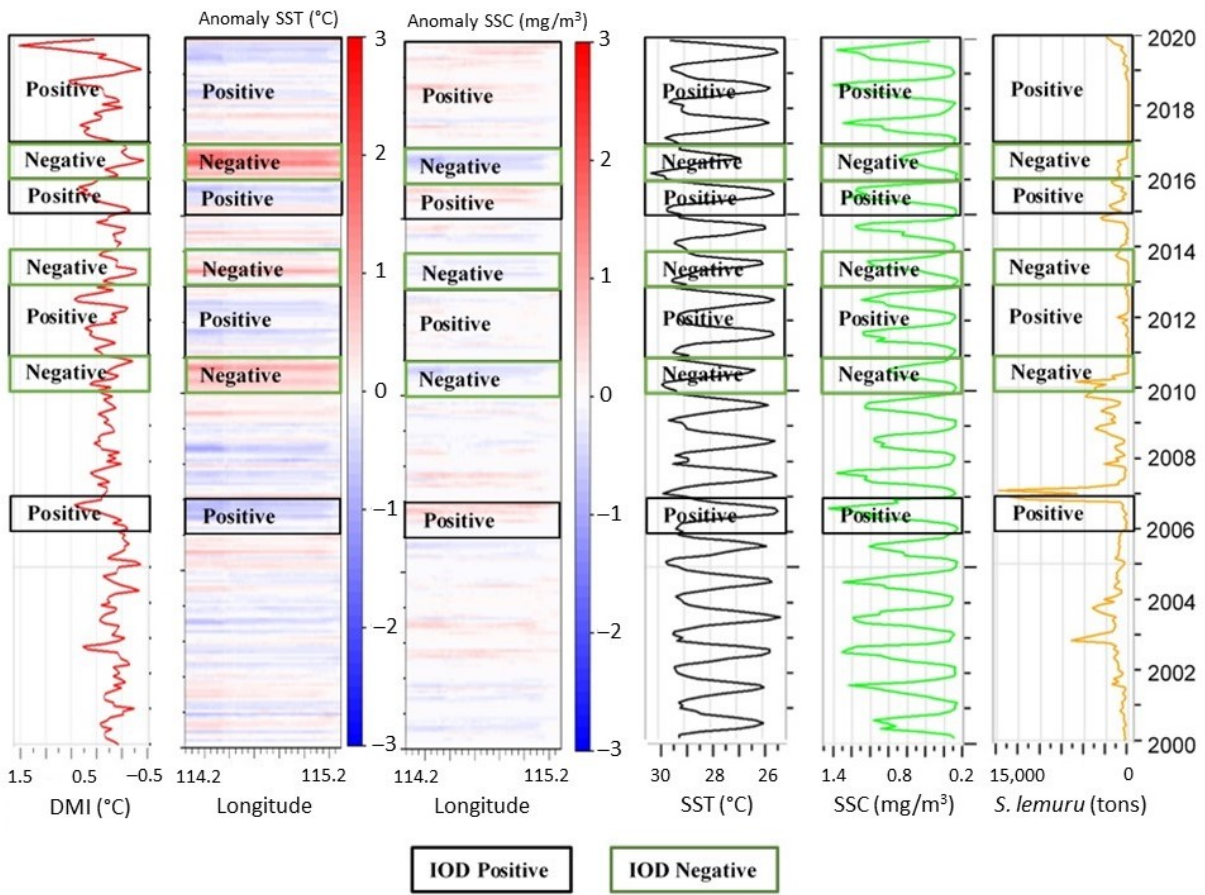
Figure 2. Variability of Dipole Mode Index (DMI) (°C), SST anomaly (°C), SSC anomaly (mg/m 3 ), SST (°C), SSC (mg/m 3 ), and Sardinella lemuru (tons) in the Bali Strait.